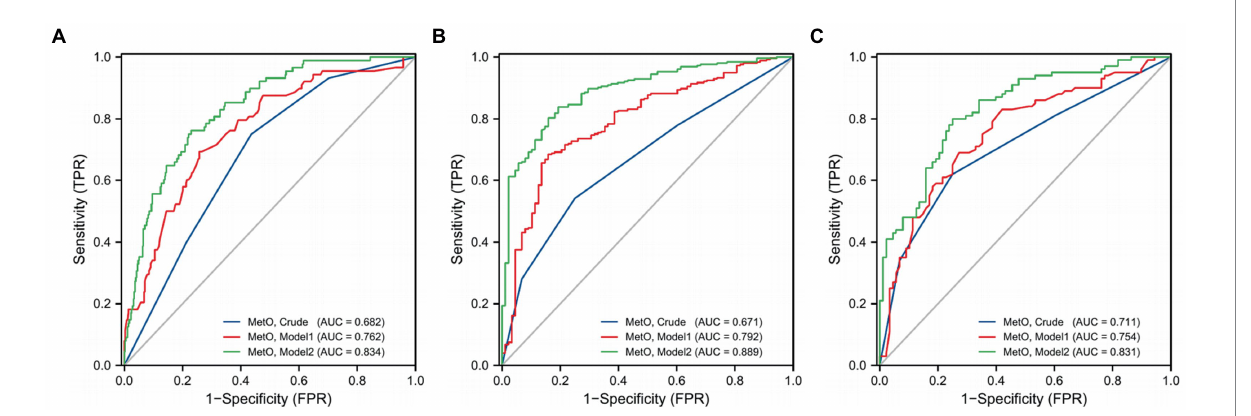
FIGURE 6 ROC curves of MetO quartiles in different models for the risk of MMD and its subtypes. (A) MMD overall; (B) Ischemic-type; (C)